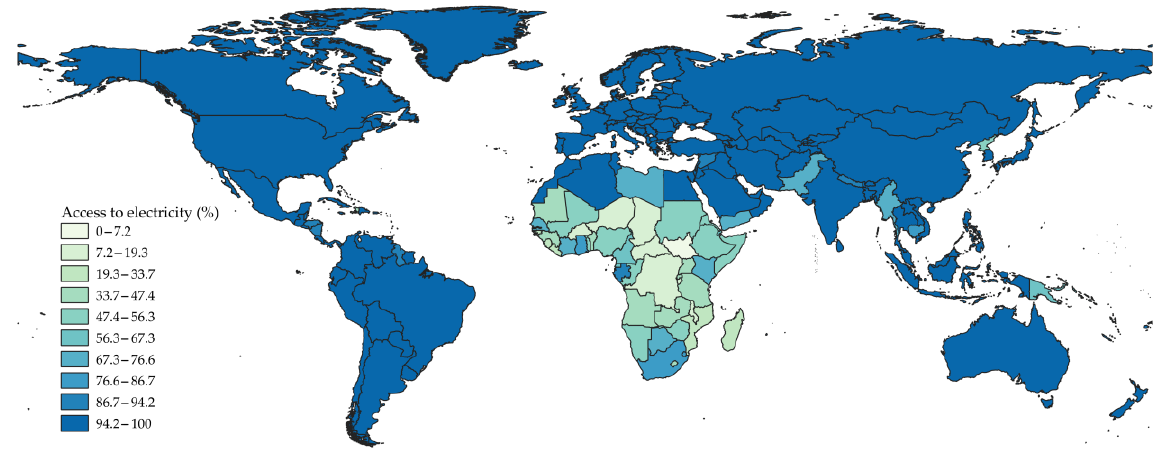
Figure 2. Share of population with access to electricity by country (2020). Own work based on data from: [23].